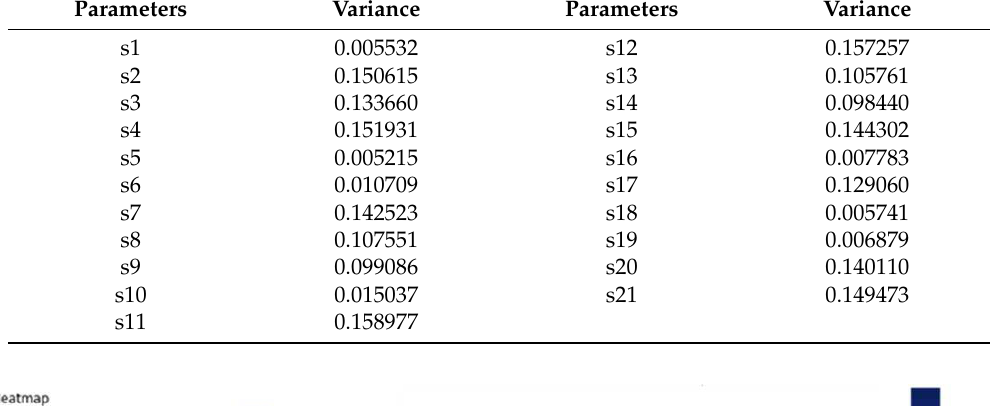
Table 2. Variance of normalized parameters.